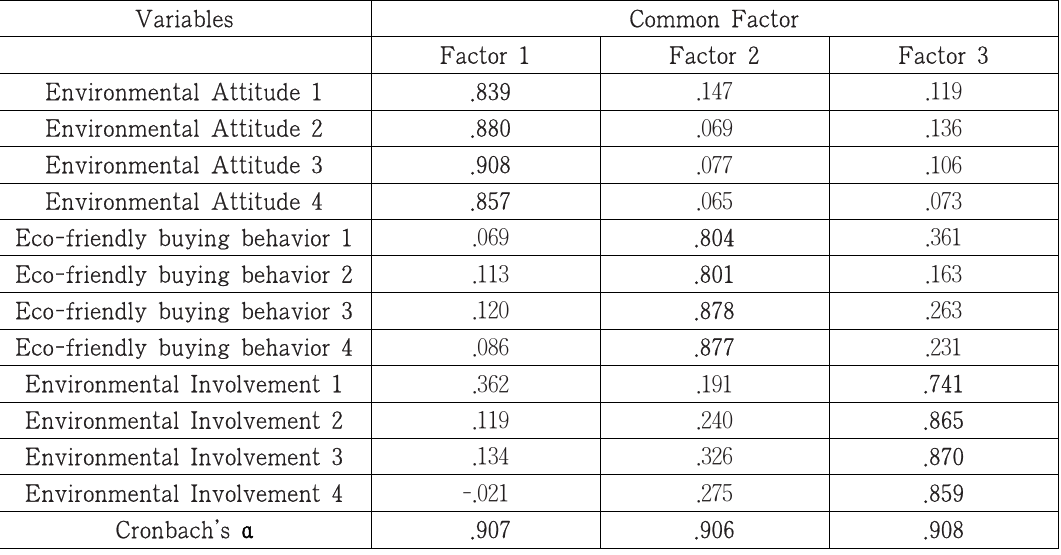
<Table 3> Validity & reliability analysis of environmental attitudes, involvement and eco-friendly buying